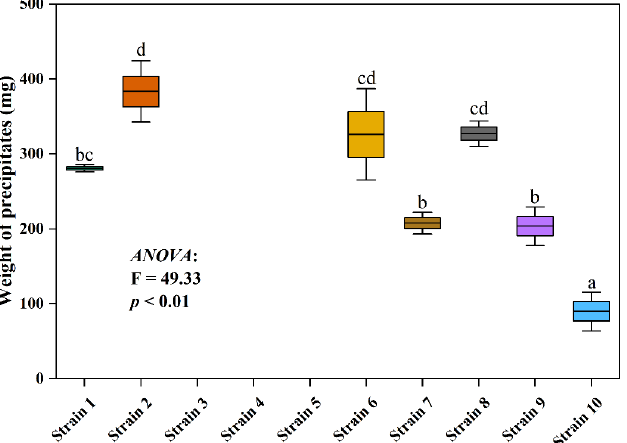
Figure 3. Weight of the precipitates in the culture media formed by the different strains. The line in the middle of the box and the error bar represents the mean value and the standard deviation of the weight of the precipitates, respectively. Different letters indicate a significant difference in the weight of the precipitates in the culture media formed by the different strains (Tukey's HSD; p < 0.05). Different colors in the box indicate the different culture media. ANOVA, Analysis of Variance.